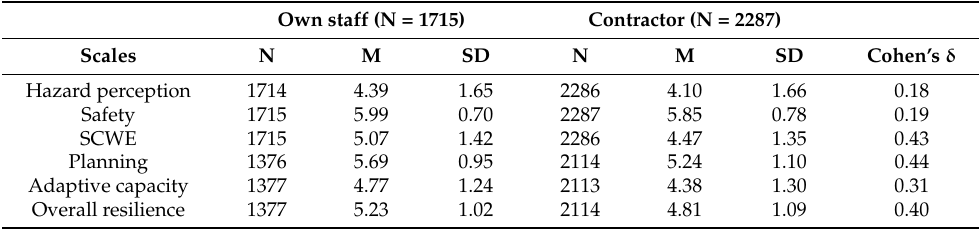
Table 10. Descriptive statistics of the scales by contractual relationship.